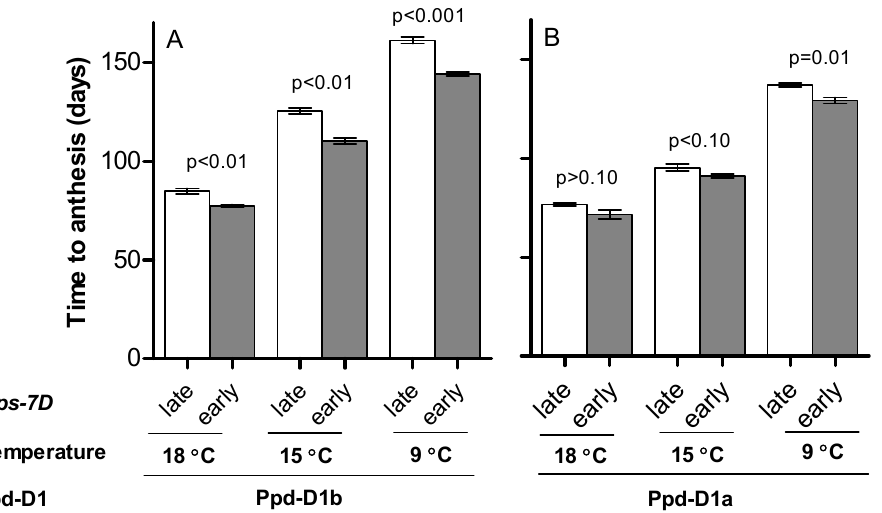
Figure 1. Duration of the whole phase from seedling emergence to anthesis for the lines carrying Eps-7D-late (open bars) or -early (closed bars) alleles with Ppd-D1b ( A ) or Ppd-D1a ( B ) alleles in the background under short day at three growing temperatures. Error bars indicate the SEM and the p -value indicates the level of significance exclusively due to the action of the Eps-7D gene within each temperature and Ppd-D1 allelic condition.